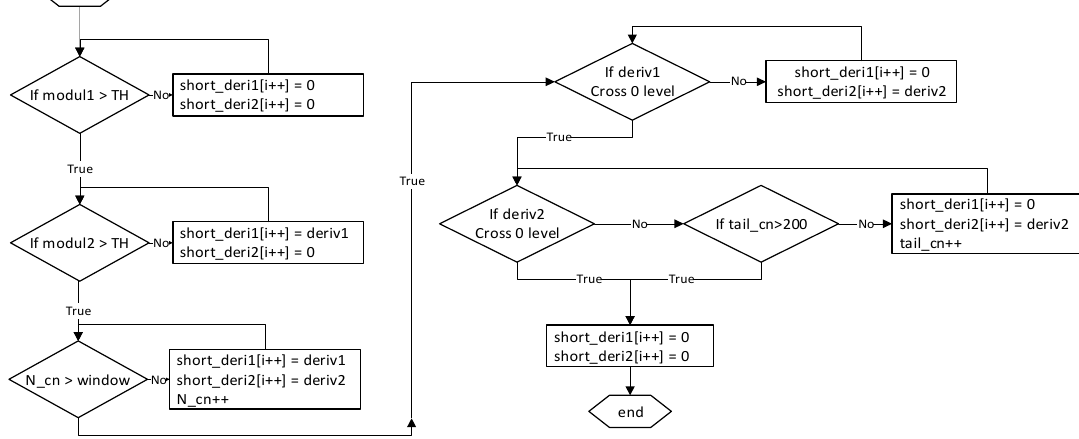
A signature cropping algorithm by window method, where modul1(2)—vector of magnetic signature magnitude, deriv1(2)—vector of di ff erence quotient of magnetic signature, short_deriv1(2)—vector of cropped derivative signal, TH—threshold value, N_cn—counter of signal vector element, window—window method parameter, tail_cn—counter for forcing the end of the recording, and i ++ —index of vector